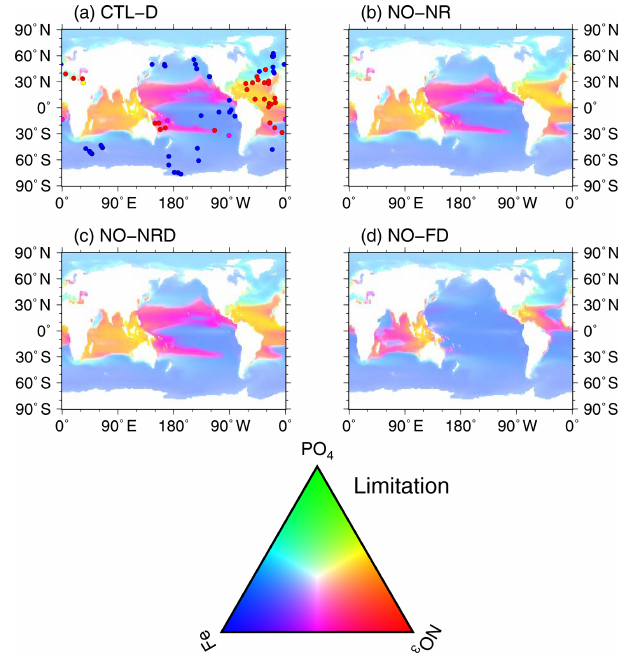
Figure 16. Limiting nutrient map for phytoplankton for (a) CTL-D, (b) NO-NR, (c) NO-NRD, and (d) NO-FD. Shading indicates lim- iting nutrient(s), e.g., red: N limitation, blue: Fe limitation, green: P limitation, magenta: N and Fe limitation, cyan: Fe and P limita- tion, yellow: P and N limitation (see bottom color triangle). Circles in (a) represent observed limiting nutrients from nutrient addition experiments (Moore et al.,